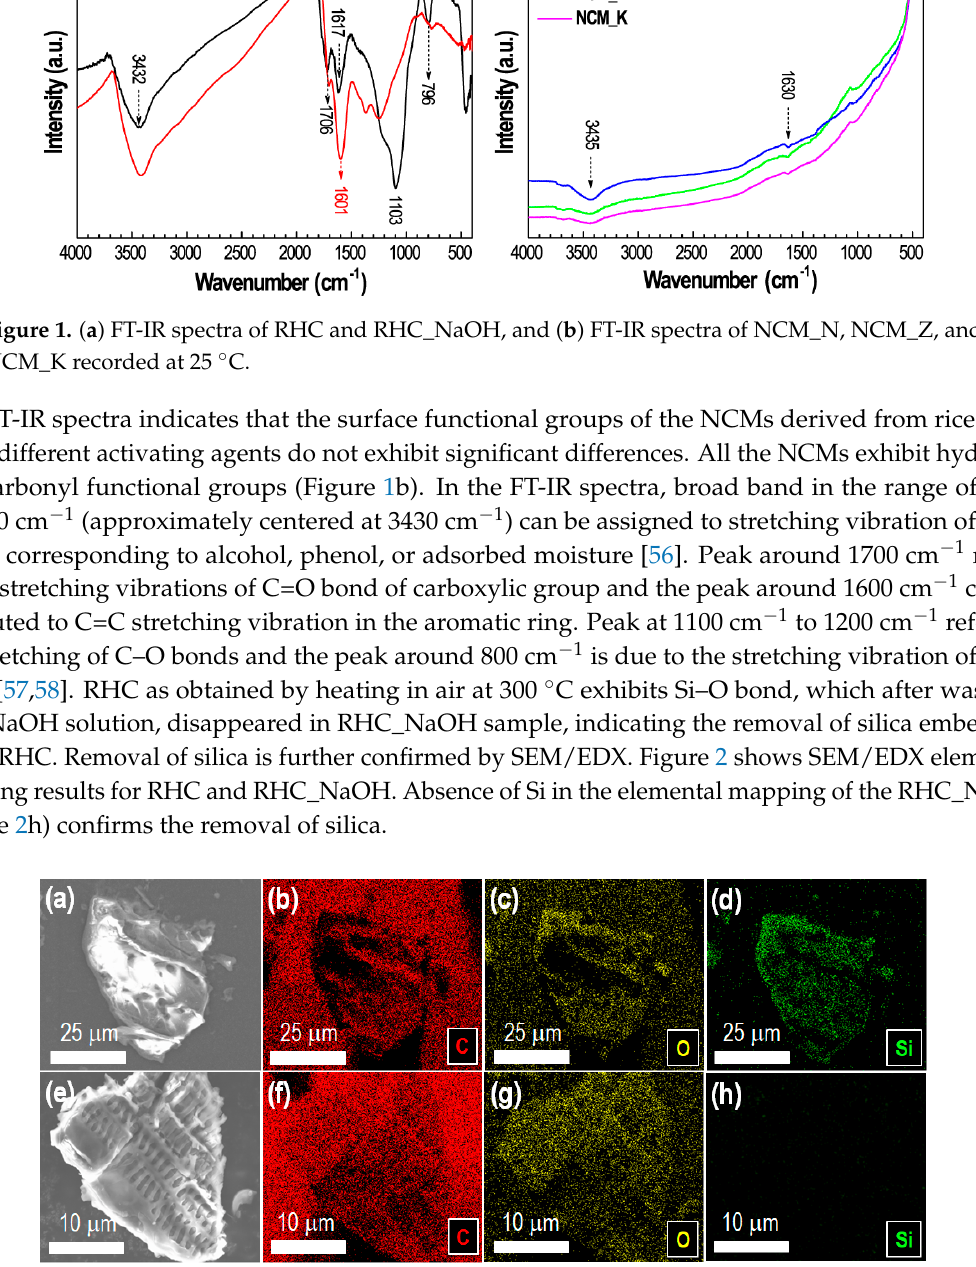
Figure 2. Results obtained from SEM/EDX. ( a ) SEM image of RHC, and elemental mapping ( b ) carbon, ( c ) oxygen and ( d ) silicon, and ( e ) SEM image of RHC_NaOH, and elemental mapping ( f ) carbon, ( g ) oxygen, and ( h ) silicon.